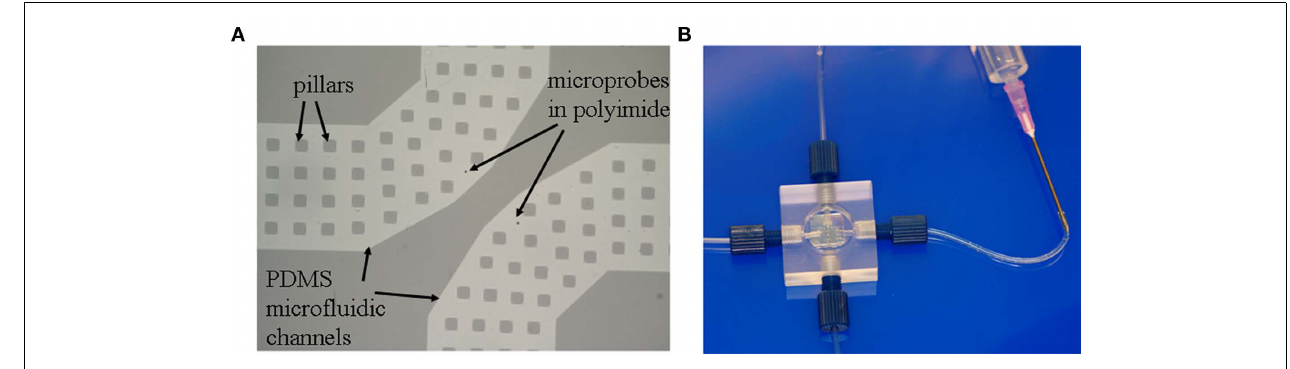
square pillars part of the PDMS structure. (B) The chip is packaged in a Plexiglas enclosure with a top cell culture vial and a dedicated input and output for each aperture. Figure 4A adapted from Martinez et al. (2010).